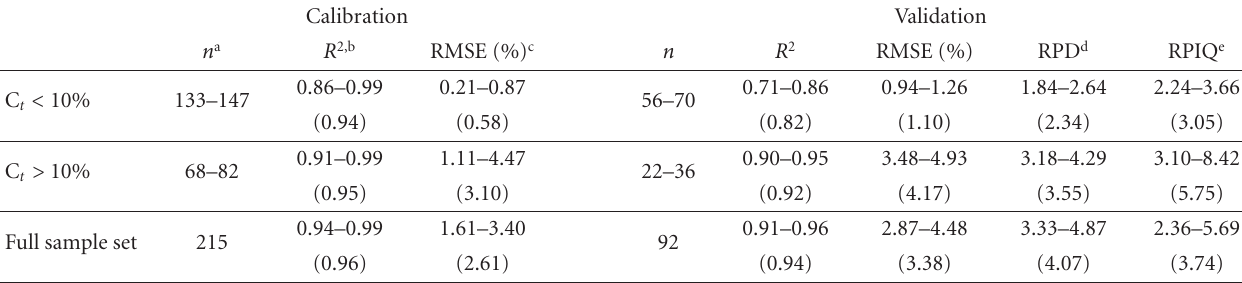
Table 3: Detailed partial least squares regression model results for soil total carbon (C t ) prediction from the subsets of mid-infrared di ff use reflectance spectra based on C t content. The range of values reflects the results of 10 random iterations of the models, and the number in parentheses is the mean. Detailed results are also given for full sample set models with no subsetting for